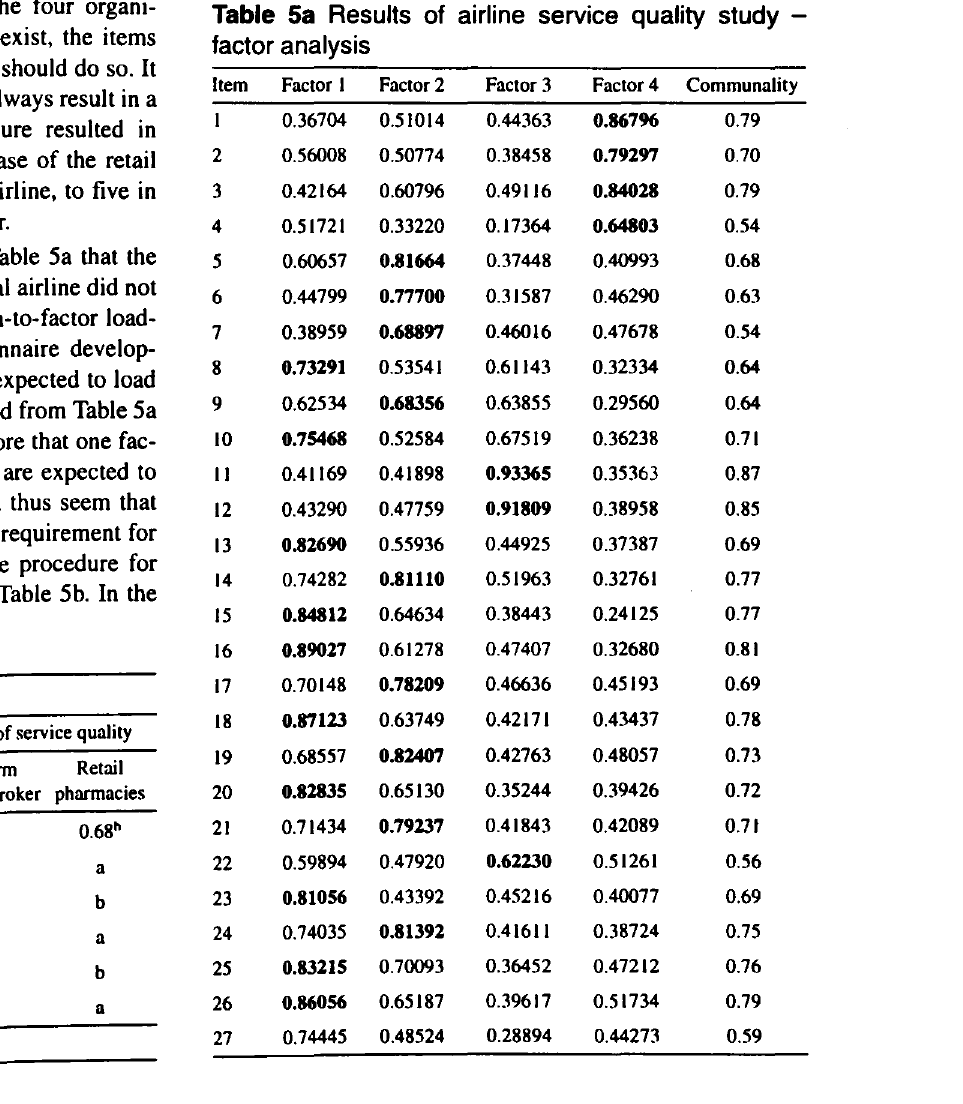
Multiple regression of dimensions on overall evaluation of service quality